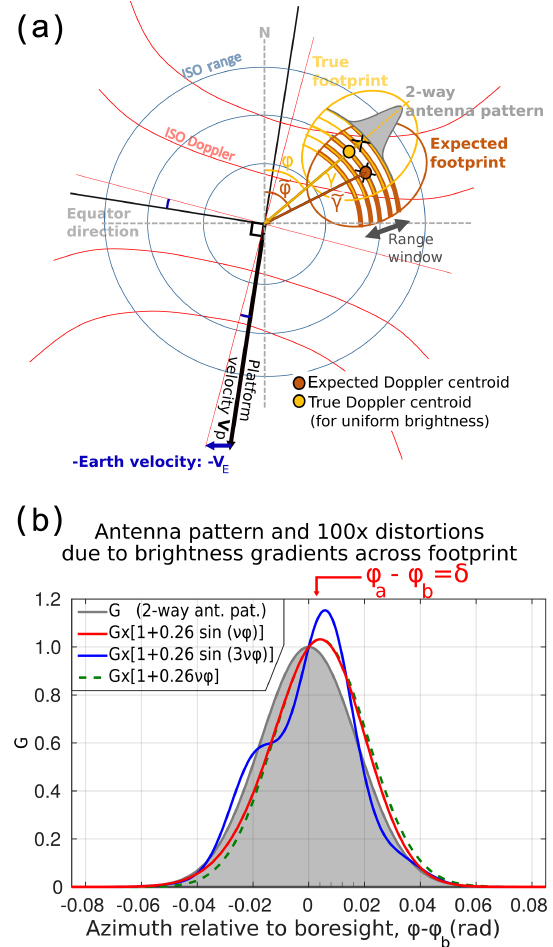
Figure A1. (a) True pointing. The attitude drift changes the antenna footprint direction and shifts the DFS centroid. Here γ and ϕ are the expected coordinates of the antenna gain ground projection, while ˜ γ and ˜ ϕ are the shifted versions of these coordinates by the atti- tude misknowledge (adapted from Ardhuin et al., 2019b). (b) Ap- parent pointing ϕ a for the SKIM geometry. Examples of two-way antenna gain G as a function of azimuth and distortions (exagger- ated 100 times) induced by σ 0 gradients on the power integrated by the radar in the azimuth direction across the antenna diagram (gray curve). Three examples of asymmetric distortions are given: a sine function with ν = sin θ/σ α , a sine function varying 3 times faster and a linear trend. Such distortions induce an apparent mispoint- ing of the beam δϕ and a correction to the geometrical line-of-sight relative velocity